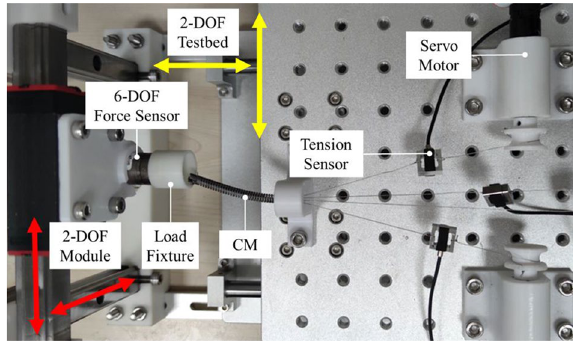
Figure 4. Training data acquisition platform.